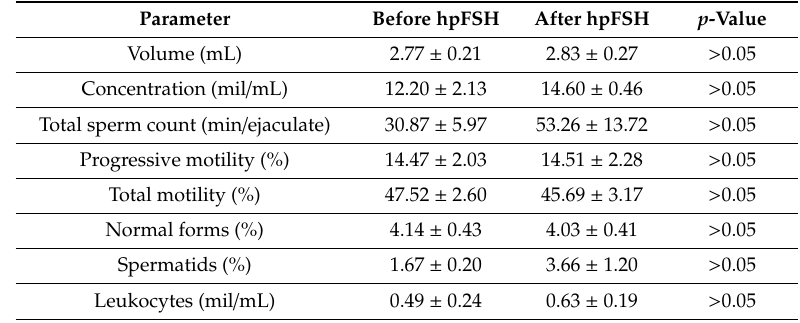
Table 1. Conventional sperm parameters before and after treatment with follicle-stimulating hormone (hpFSH) in the entire patient cohort.